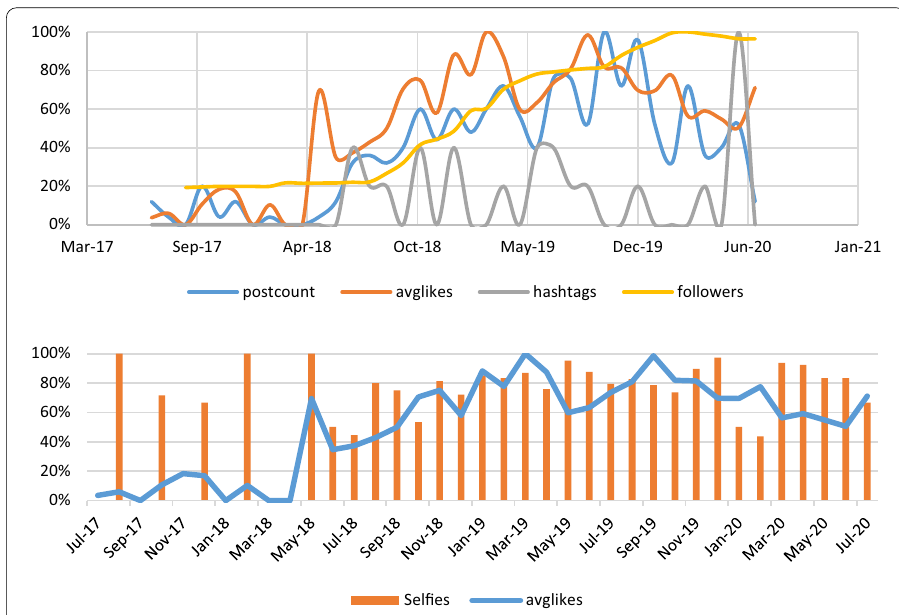
Fig. 16 Sharing behaviors of P2 with average number of likes over time